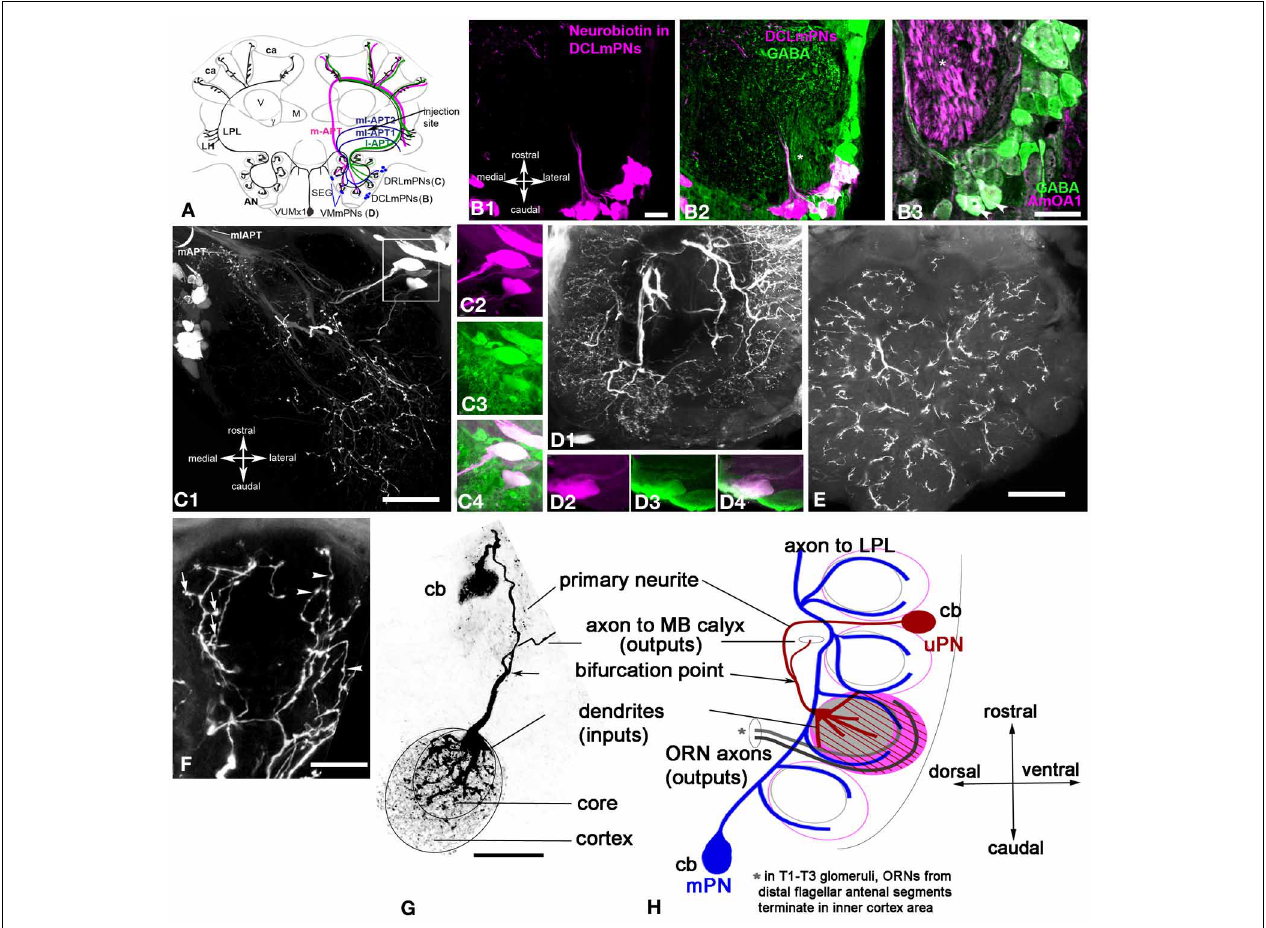
FIGURE 5 | Apis mellifera. The mPNs branching in the glomeruli as revealed by neurobiotin injection into the lateral protocerebral lobe. (A) Schematic of the honey bee brain that illustrates octopaminergic neurons that branch in the antennal lobe, lateral protocerebral lobe (LPL) and calyx of the MB. Neurobiotin injected into the LPL revealed three groups of neurons named as follow DCLmPNs (B1) , DRLmPNs (C1) , and VMmPNs (D1) . A subpopulation of the neurobiotin injected neurons from DCLmPNs (magenta B1 and B2 ) were co-labeled with GABA (green). (B3) A higher magnification of the GABA neurons co-stained with anti-AmOA1: arrowheads indicate the GABAergic DCLmPNs neurons that co-labeled with anti-AmOA1. (C1) There are three neurons in the DRLmPNs group that are located dorsally in a lateral cluster of the most caudal part of the antennal lobe. These neurobiotin labeled neurons ( C2 , magenta) are co-stained with anti-GABA ( C3 , green single image). (C4) The merged image shows the anti-GABA (green) and neurobiotin (magenta) labeled neurons. (D) An image from the brain section of the antennal lobe where